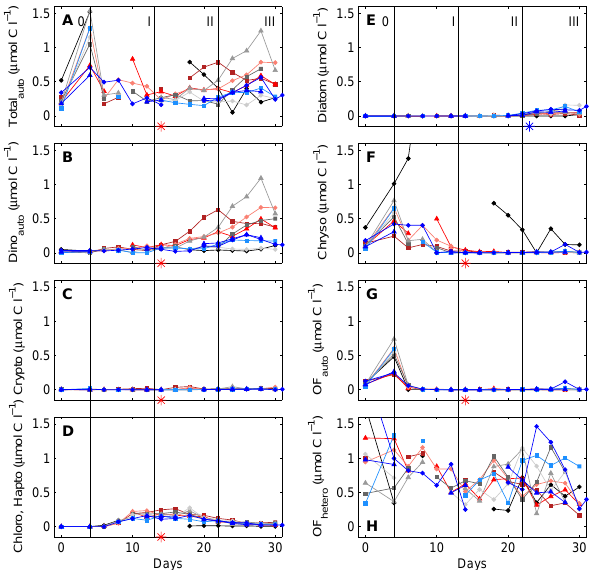
Fig. 11. Temporal development of depth-averaged (0.3–12m) plankton carbon biomass of all autotrophs (A) , autotrophic di- noflagellates (B) , cryptophytes (C) , chlorophytes or haptophytes (D) , diatoms (E) , chrysophytes (F) , autotrophic flagellates other than dinoflagellates (G) , and heterotrophic flagellates (H) as counted by light microscopy. Style and colour code follow those of Fig. 6, and statistical results are summarized in Table